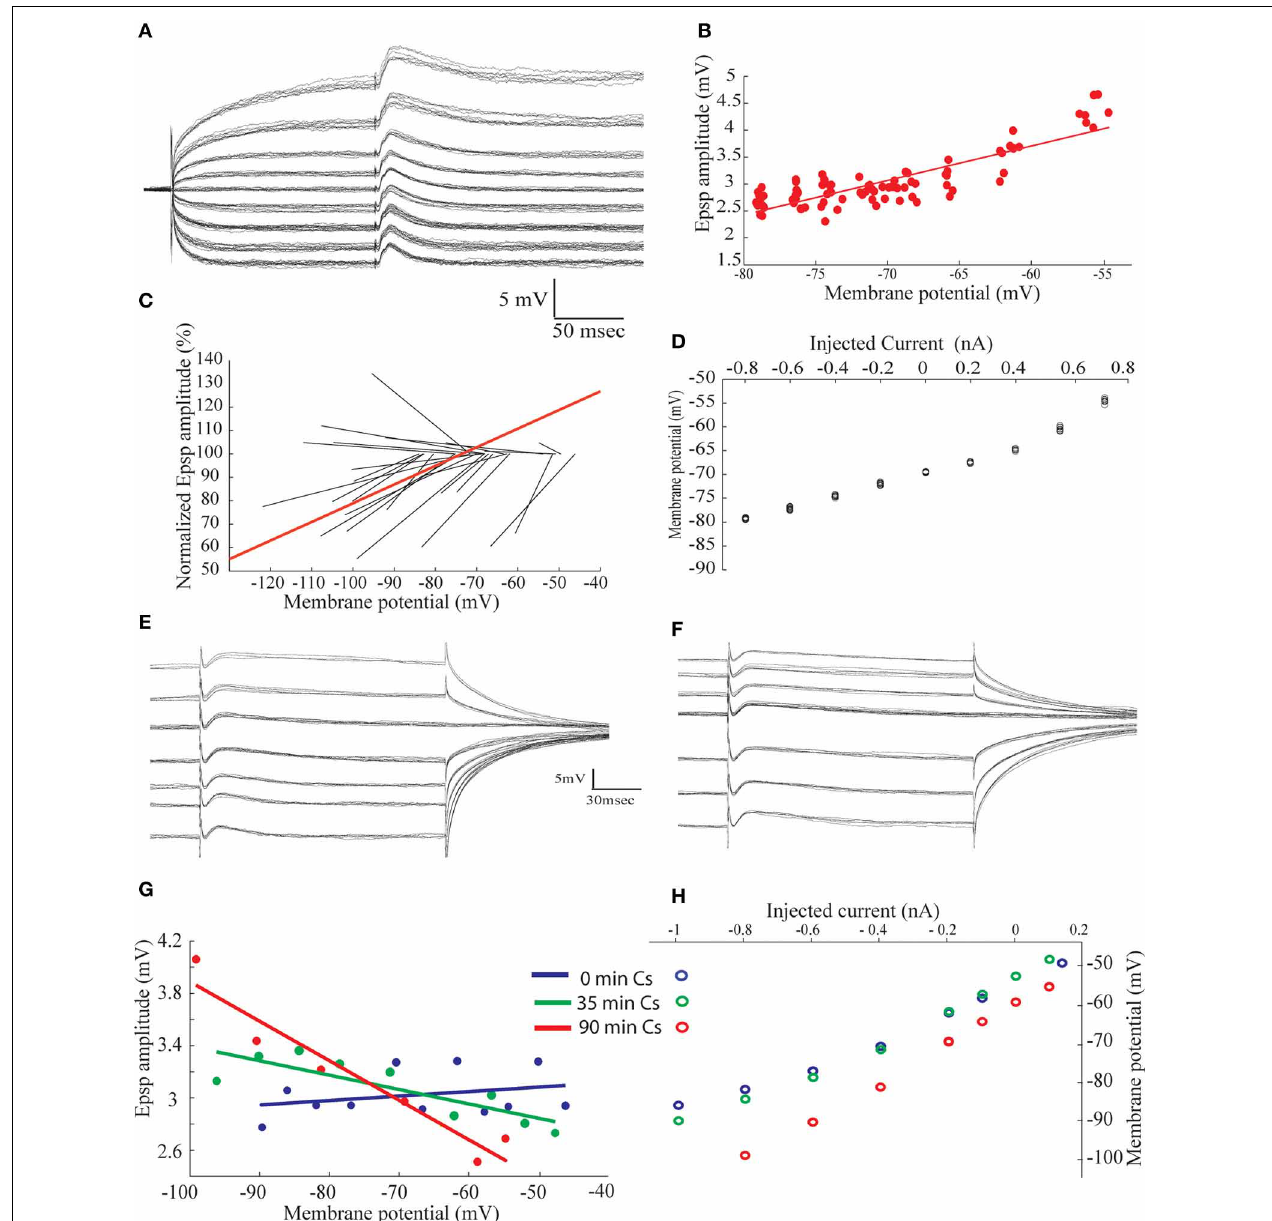
FIGURE 6 | The amplitude of the excitatory synaptic potentials evoked by afferent nerve stimulation increases with membrane depolarization. (A) Synaptic potentials response evoked by afferent nerve stimulation recorded at different membrane potentials. (B) The amplitude of the synaptic potentials plotted as a function of the membrane potential. (C) Normalized regression lines of the voltage dependent of the synaptic potentials measured in 24 neurons. Red line is the calculated average relationship. (D) The voltage current